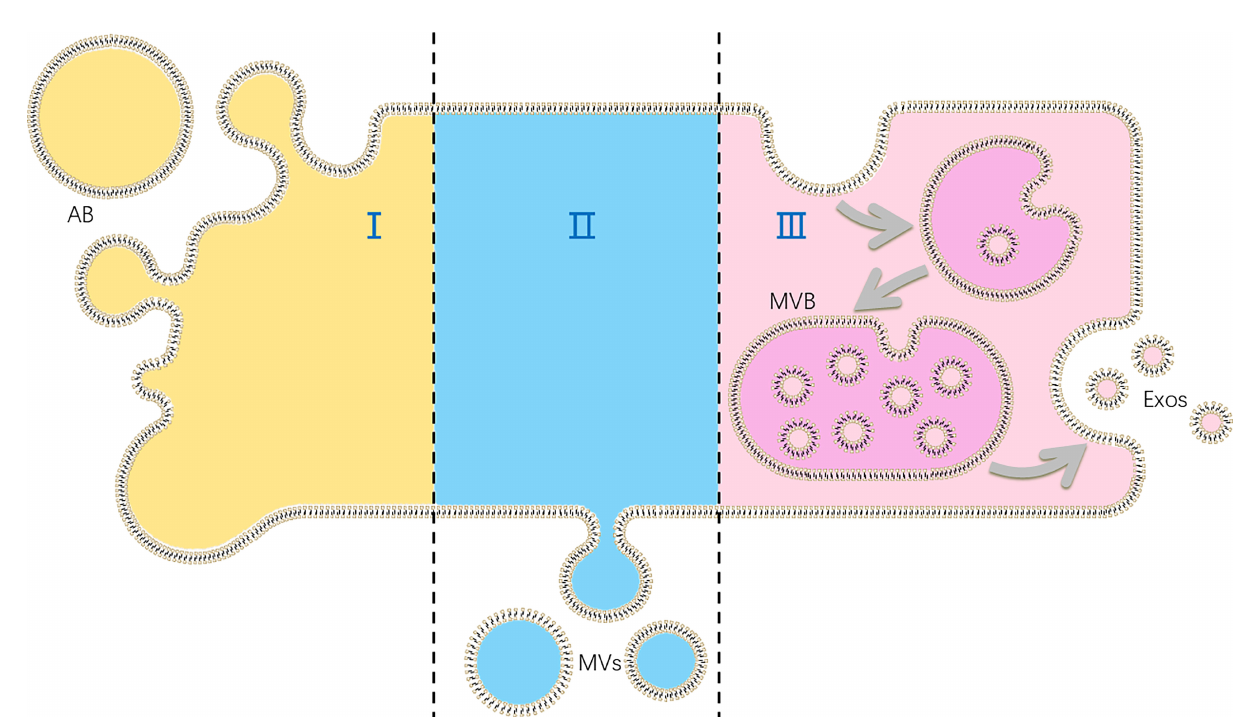
FIGURE 1 | The production of different kinds of extracellular vesicles (EVs): (I) apoptotic bodies (ABs) are formed in cell apoptosis; (II) microvesicles (MVs) are shed directly by cells; (III) exosomes (Exos) are released as multi-vesicular body (MVB) fuse with plasma